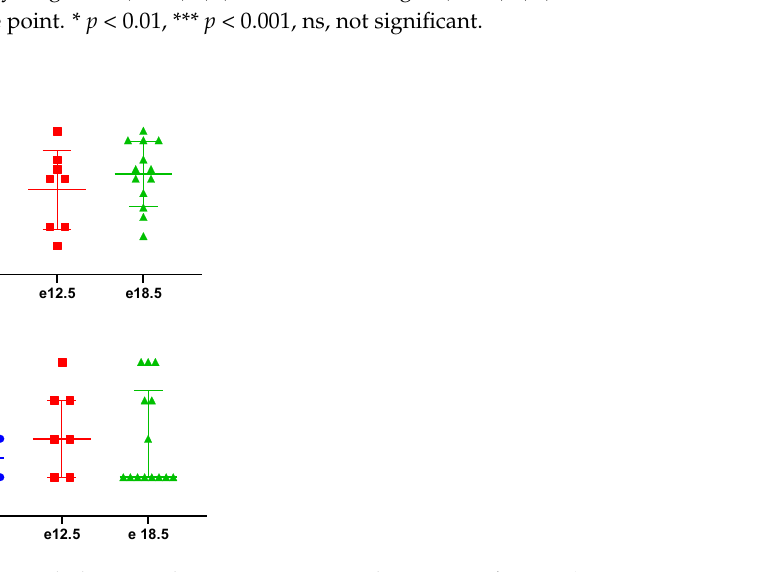
Figure 2. Clinicopathologic markers in NP, e12.5, and e18.5 BPH/5 mice ( n = 8–15 per group). There was no evidence of ( A ) anemia or ( B ) progressive thrombocytopenia during pregnancy. Packed cell volume (PCV).